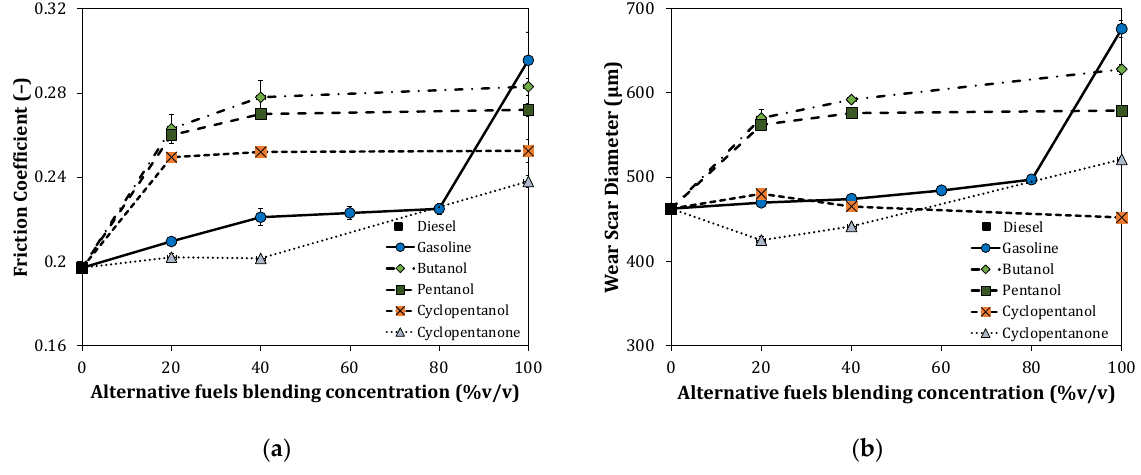
Figure 1. ( a ) Friction coefficient and ( b ) wear scar diameter of the neat tested fuels and their blends with diesel (i.e., 0: neat diesel, 100: neat alternative fuel).